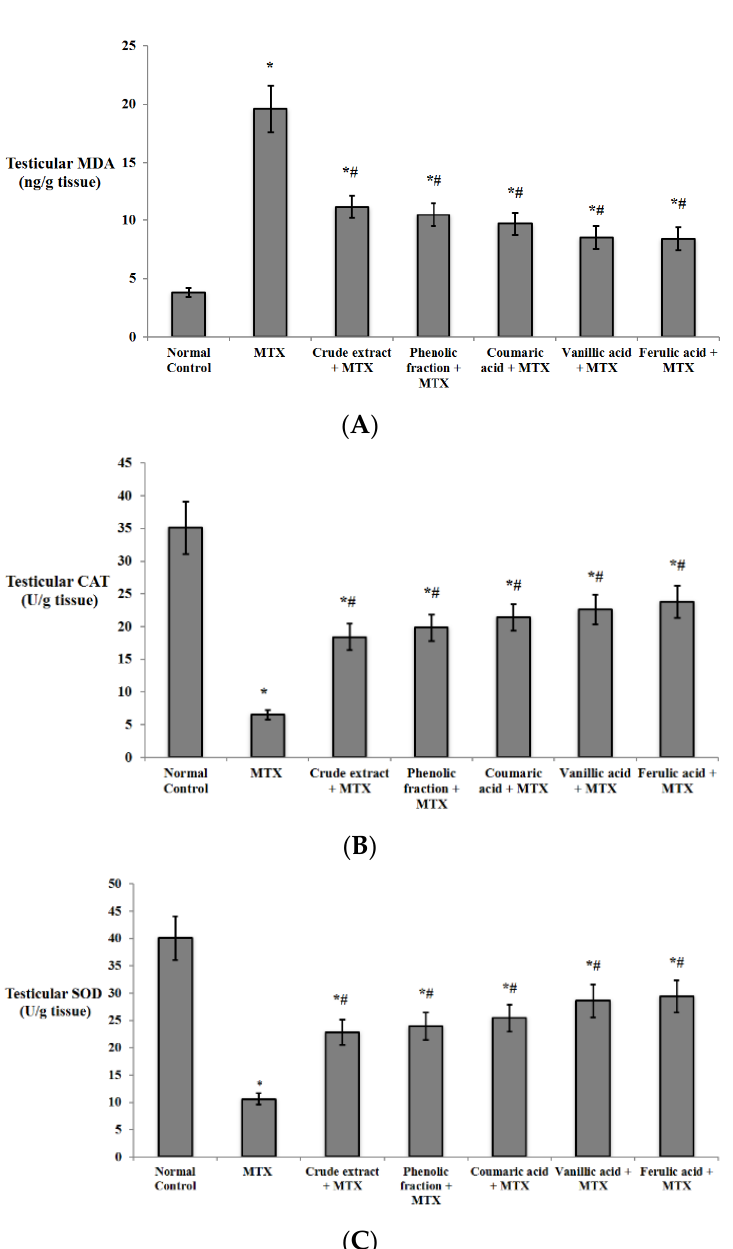
Figure 6. Effects of C. endivia L. crude extract, phenolic fraction, and its isolated compounds (coumaric, vanillic, and ferulic acids) on the testicular oxidative stress biomarkers in the experimental mice. ( A ) MDA, ( B ) CAT, and ( C ) SOD. Data are expressed as the mean ± SD. Data were analyzed using one-way ANOVA then Bonferroni’s post hoc test. * Significant against normal control group, # significant against MTX control group. Values were considered different significantly at p < 0.05. MDA: malondialdehyde, CAT: catalase, SOD: superoxide dismutase.